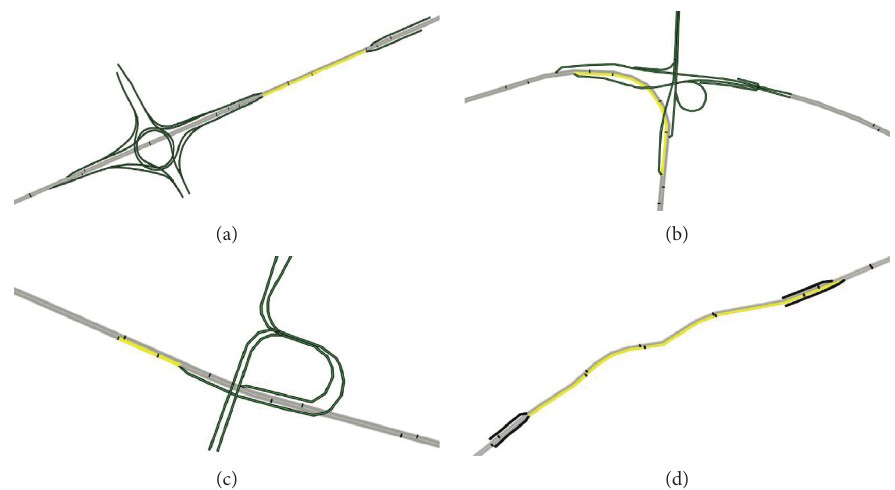
Figure 16: Spatial structures of critical road segments: (a) r